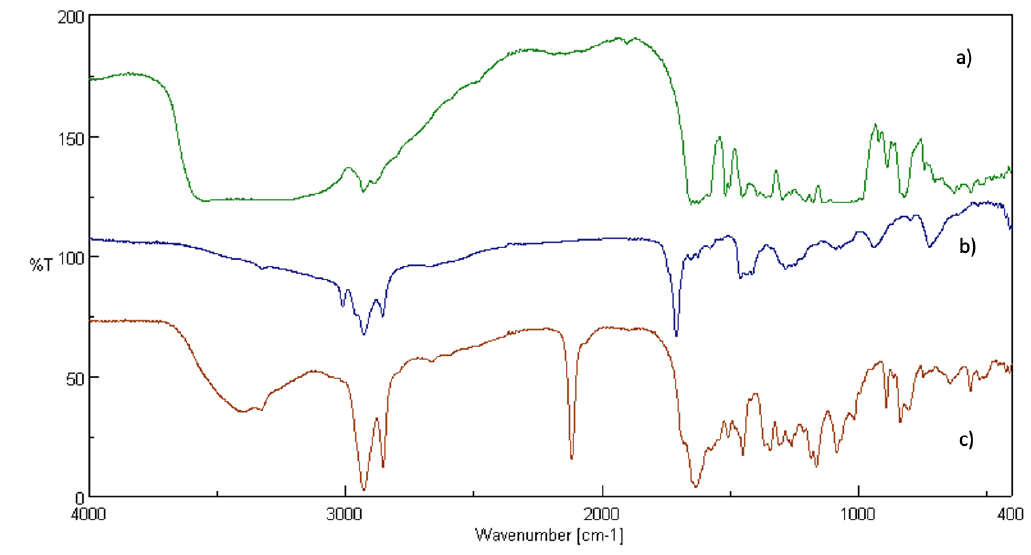
Figure 1. Fourier-transform infrared spectroscopy (FT-IR) spectra of: naringenin ( a ), linolenic acid ( b ), ester ( c ).